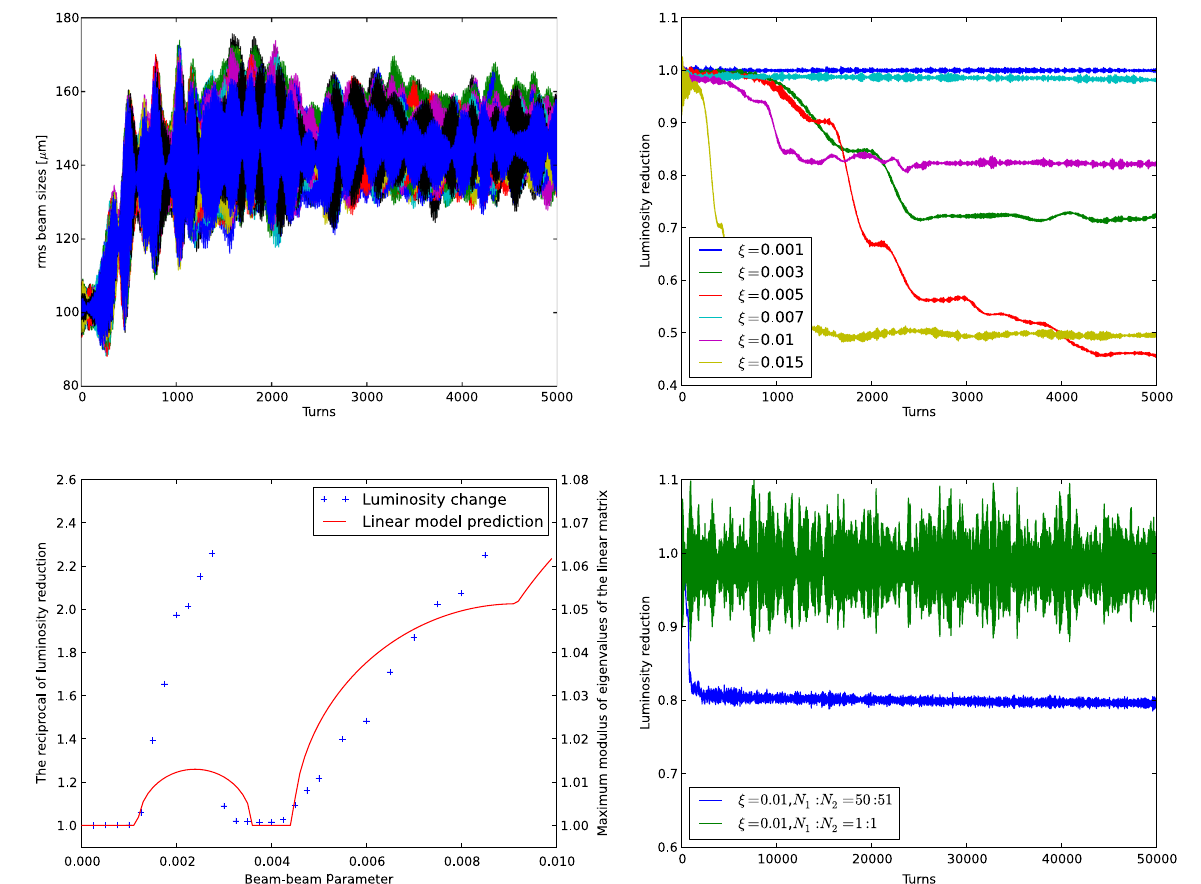
FIG. 5. The results of nonlinear 1D beam-beam simulation for ð N 1 ; N 2 Þ ¼ ð 50 ; 51 Þ . Top left: the beam size evolutions for ξ ¼ 0 . 015 , which indicates instability of the beam size. Top right: the luminosity reduction due to the second-order moment instability in asymmetric collision scheme. Bottom left: the reciprocal of luminosity reduction at the end of 5000 turns and the comparison with linear matrix model. The beam-beam parameter in the nonlinear simulation is scaled by 0.5 in this plot. Bottom right: comparison of the asymmetric and symmetric collision scheme. The tunes of two rings are all set to 0.68 to avoid lower order nonlinear resonances.